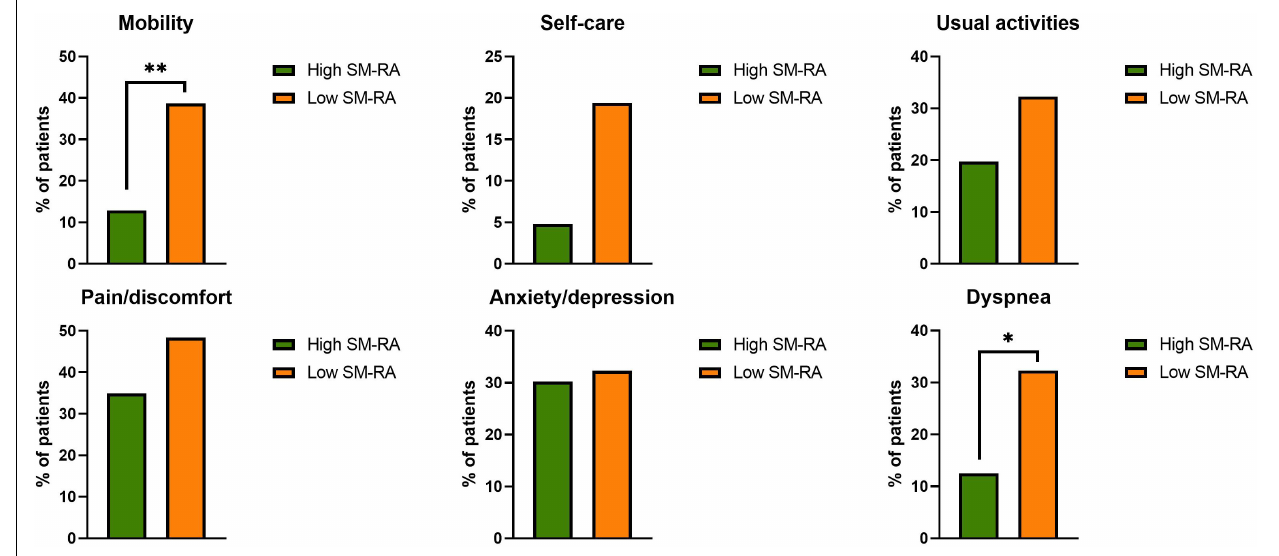
FIGURE 2 | Proportion of patients with any problems in the EQ-5D dimensions (mobility, self-care, usual activities, pain/discomfort, anxiety/depression) and proportion of patients with dyspnea in the group without (high skeletal muscle radiation attenuation, SM-RA) or with (low SM-RA) myosteatosis. ∗ p = 0.021; ∗∗ p =